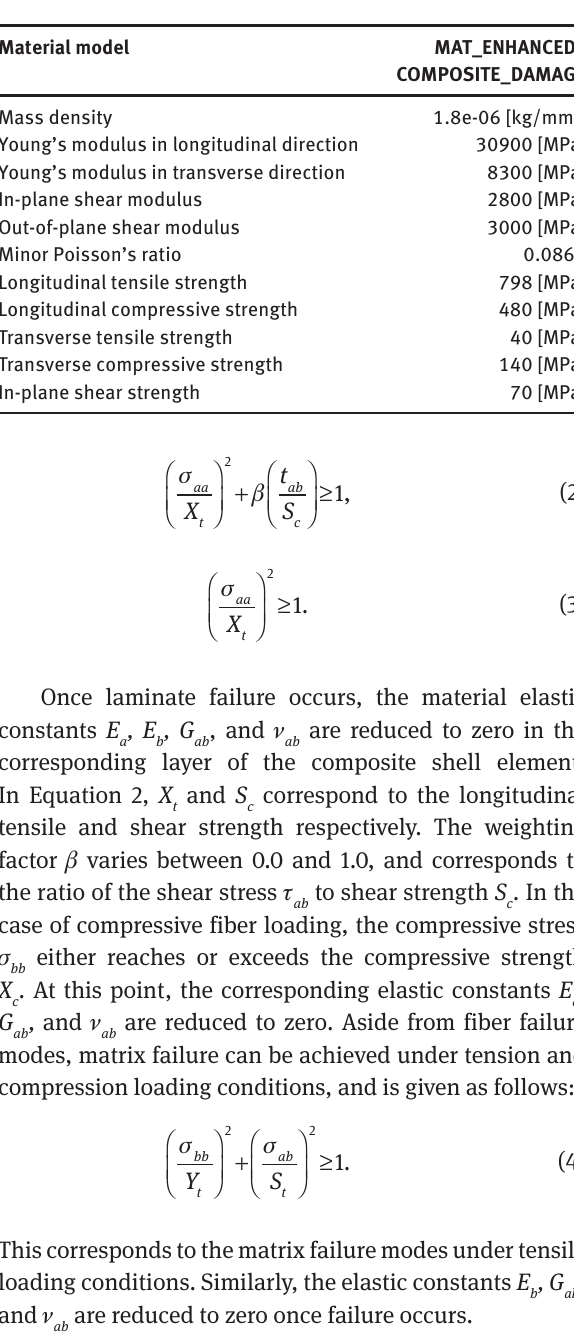
Table 2 Material properties and damage parameters for composite